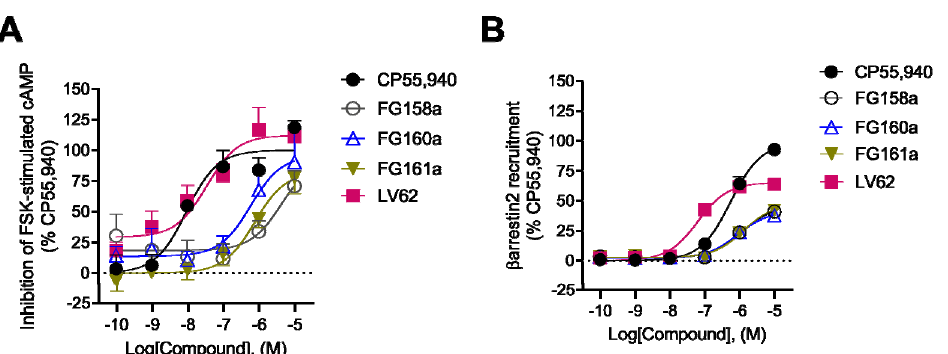
Figure 3. CB2R-dependent inhibition of FSK-stimulated cAMP and CB2R − dependent recruitment of